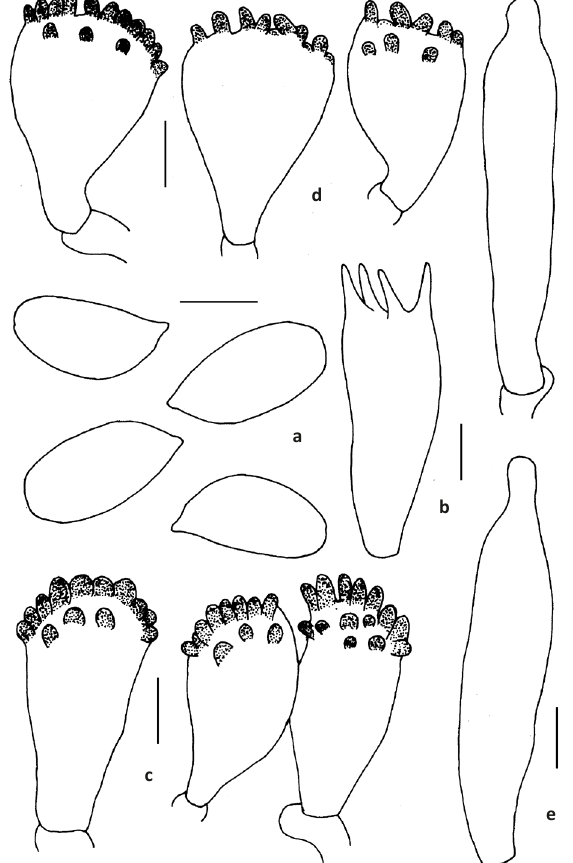
Figure 1. Micro-morphological features of Cryptomarasmius exustoides . a - basidiospores; b - basidium; c - cheilocystidia; d - Rotalis -type cells of the pileipellis; e - pileosclerocystidia (scale = 5µm). © A.K.